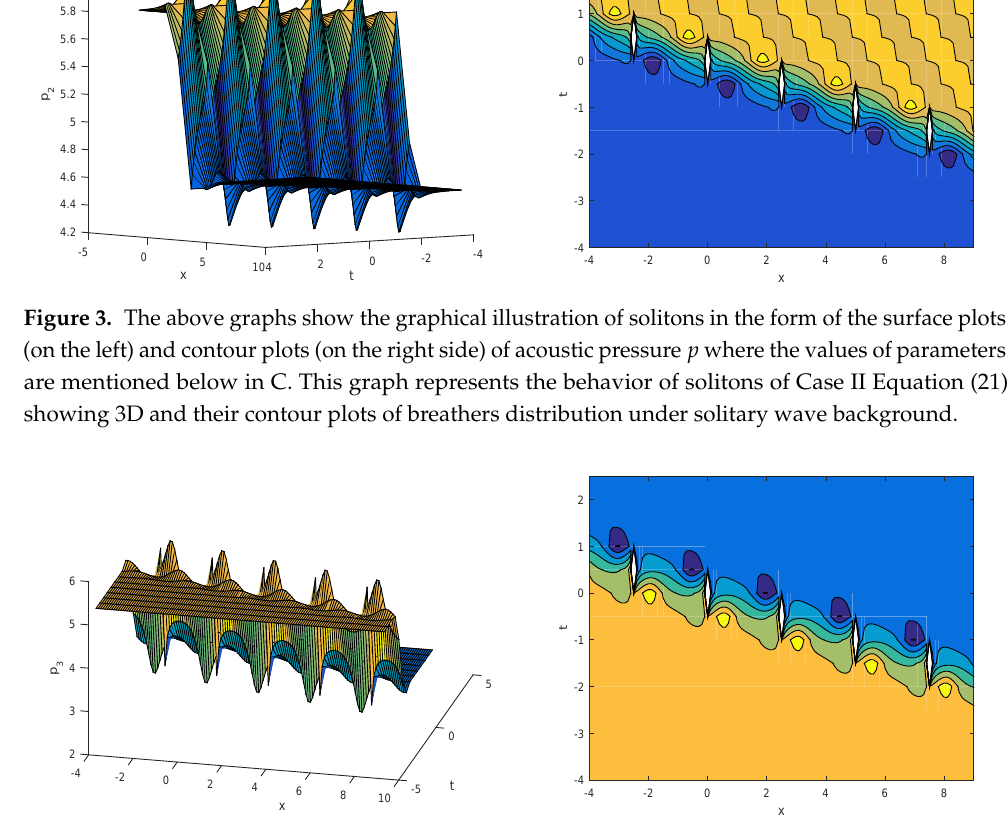
Figure 4. The above graphs show the graphical illustration of solitons in the form of the surface plots (on the left) and contour plots (on the right side) of acoustic pressure p where the values of parameters are mentioned below in D. This graph represents the behavior of solitons of Case III Equation (23) which shows 3D and their contour plots of breathers distribution under solitary wave